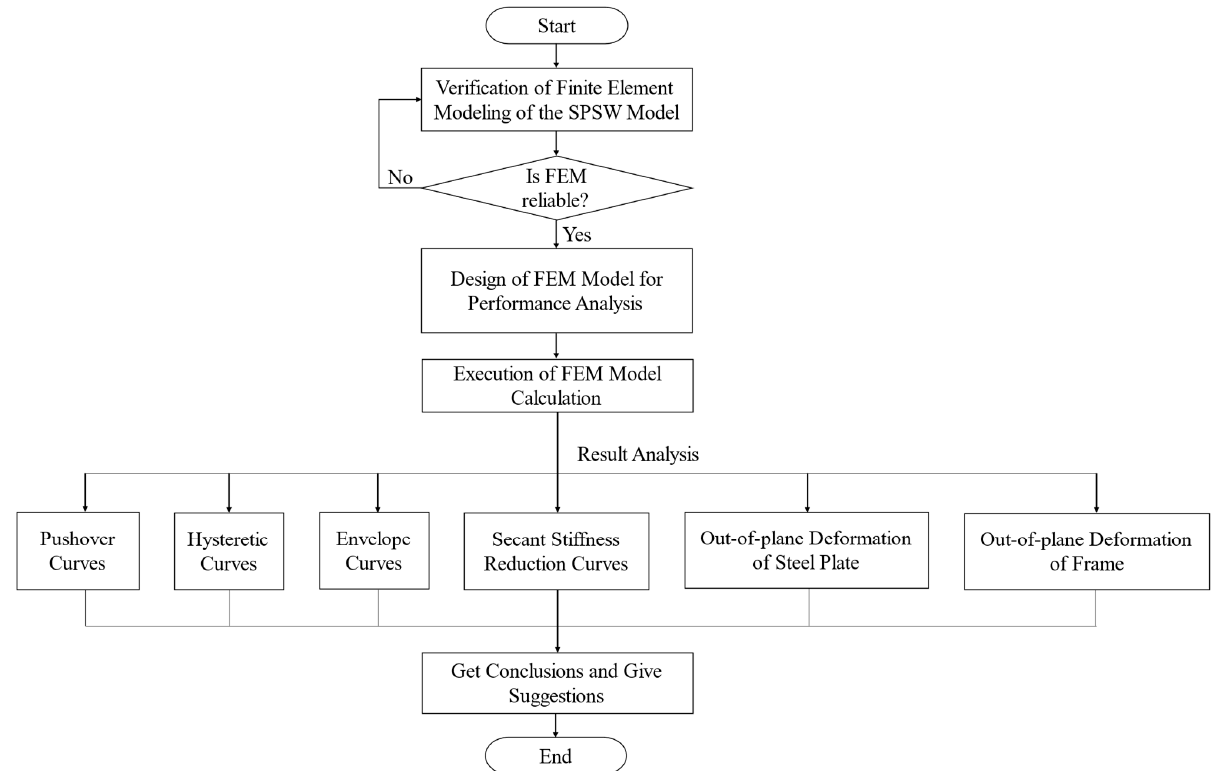
Figure 2. Structure of this article.